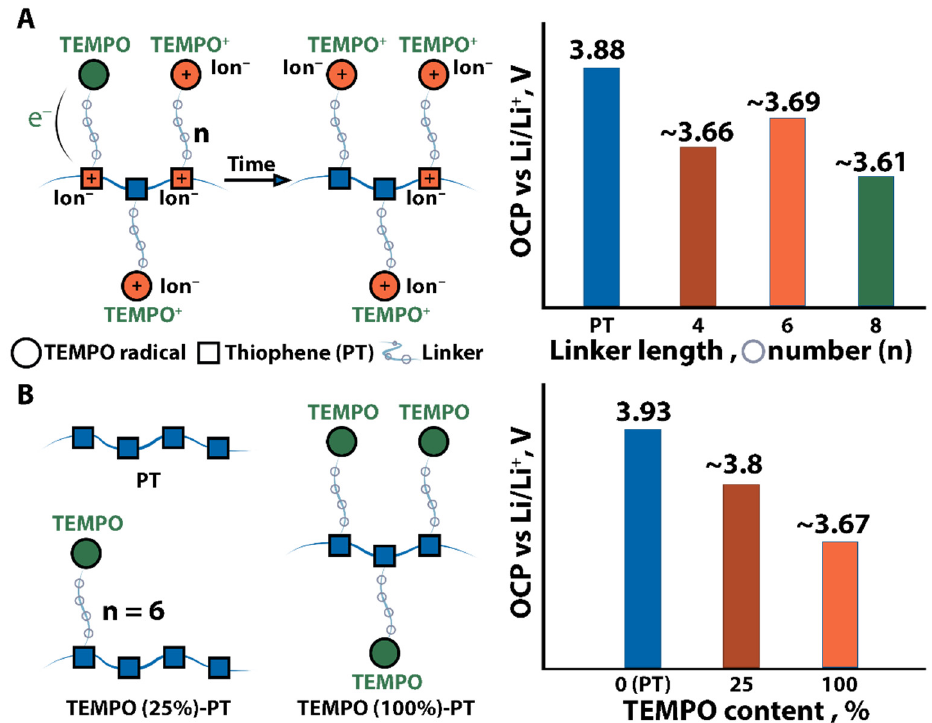
Figure 8. Schematic illustration of the internal charge transfer mechanism for TEMPO-containing polythiophenes depending on linker length ( A ) and TEMPO content ( B ).